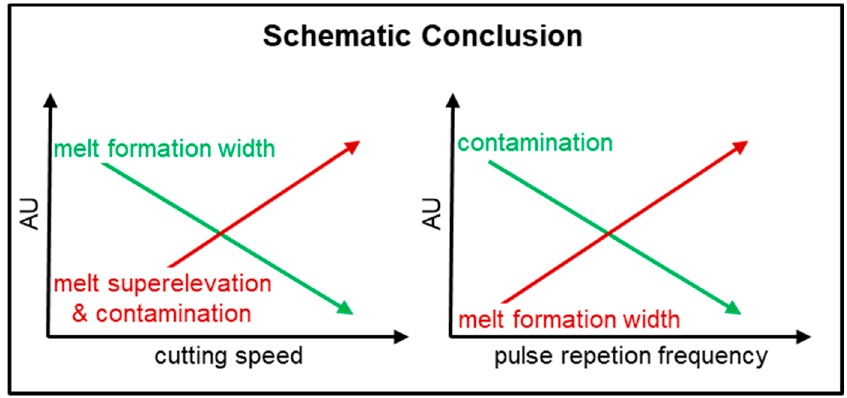
Figure 19. Graphical conclusion of the results (72.8 W, 70–490 kHz, 50–150 mm/s, 240 ns, dew point − 30 °C).